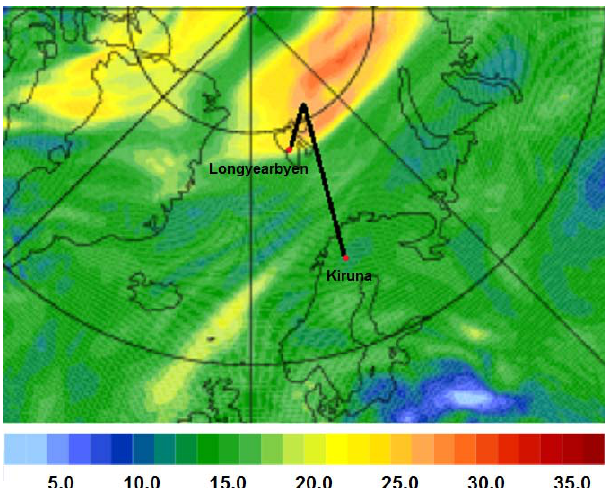
Fig. 8. Meteorological situation during RECONCILE Flight 11. The colour-coding of the map shows the scaled potential vorticity at the 450K-level (approximately 17km altitude). A late vortex remnant, coming from Canada and reaching from Spitsbergen to Siberia, can be identified clearly. The flight path of the Geophysica is indicated